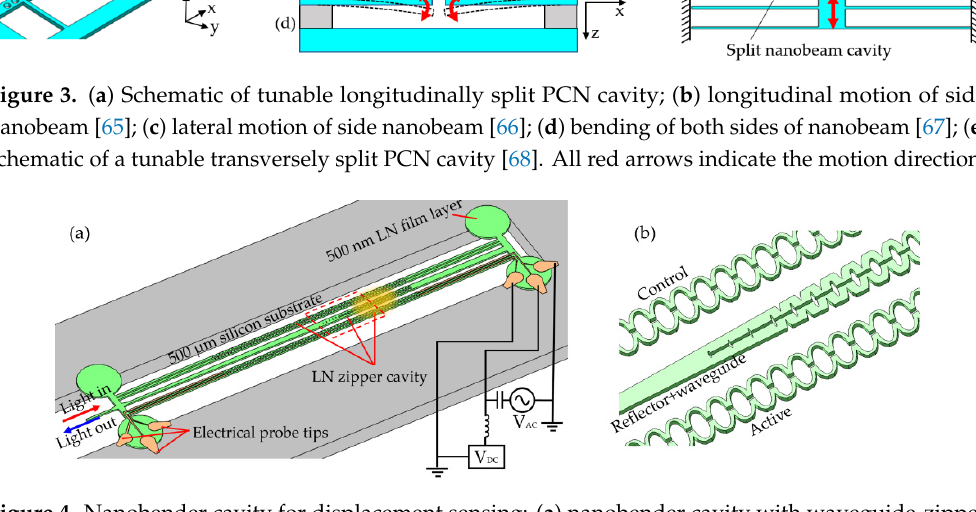
Figure 4. Nanobender cavity for displacement sensing: ( a ) nanobender cavity with waveguide-zipper PhC cavities coupling and electrical actuations; ( b ) close-up view on the zipper PhC cavities and waveguide coupling structure [96] .